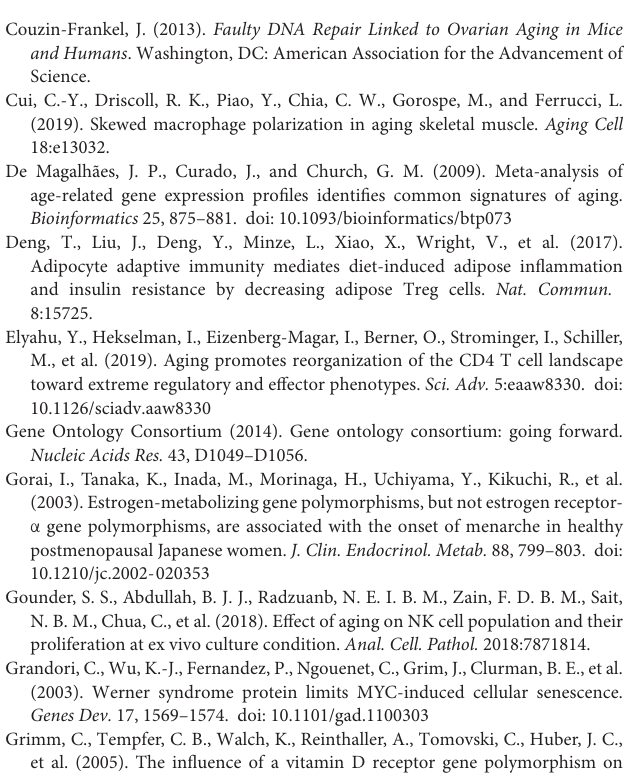
Supplementary Table 1 | The list of differentially expressed genes. Supplementary Table 2 | The list of KEGG